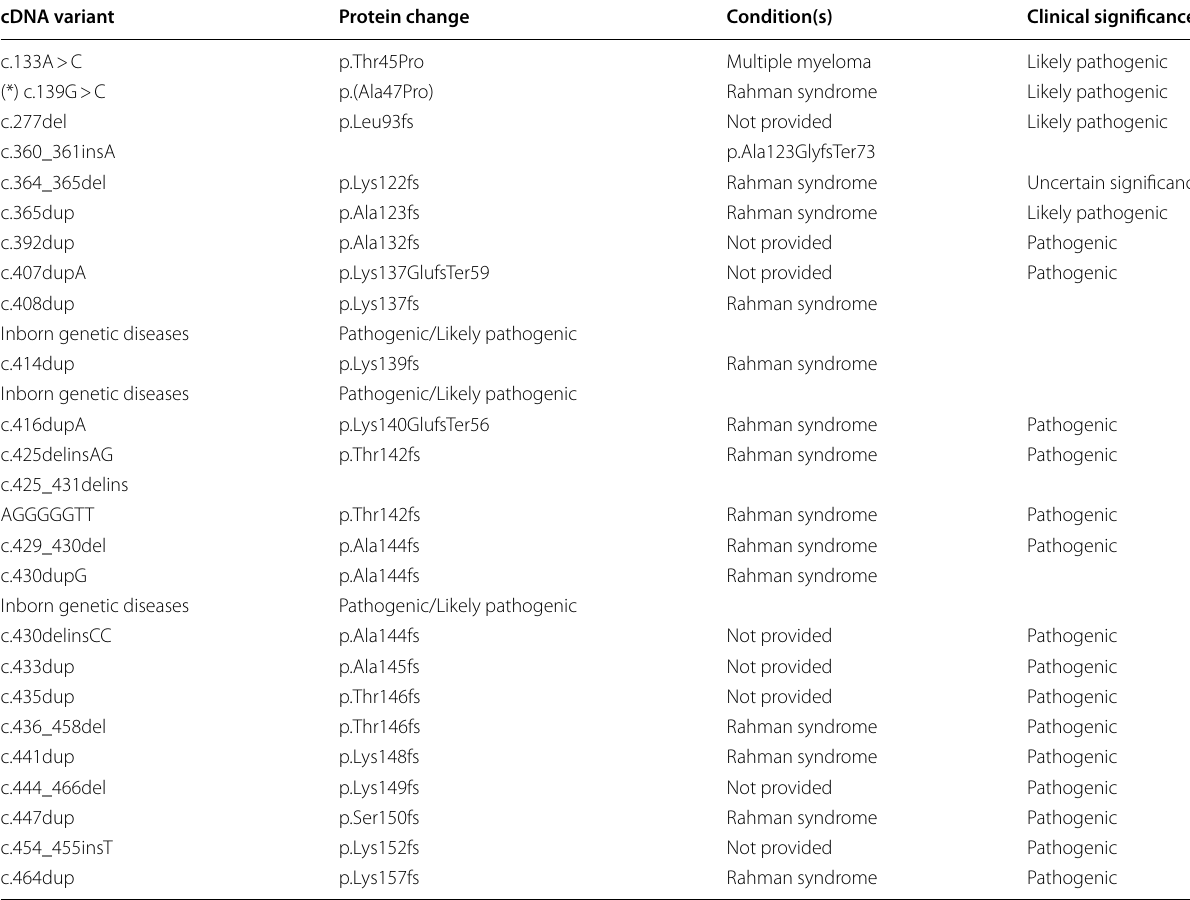
*Mutation described in this article. (Reference transcript